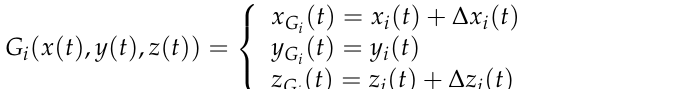
From Equations (7)–(9), the curve formed by the point where the instantaneous wear depth on the tool flank is 0 is the lower boundary of transient friction wear on the tooth flank. Using Equations (1), (7) and (8), the Equations of the micro-element cutting edge under wear conditions could be obtained. Accordingly, the boundaries of the transient friction wear can be determined, as shown in Figure 3.